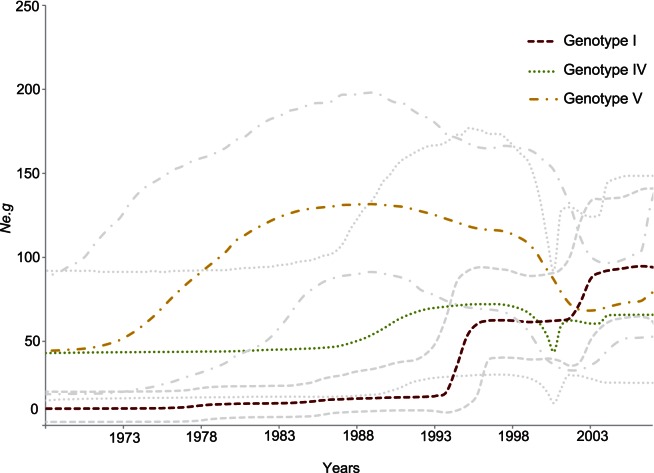
Demographic history for each genotype.Overlay of Bayesian skyline plot showing the Ne.g. (product of the effective population size and the generation length) for each DENV-1 genotypes. Ninety-five percent high probability densities (95% HPD) are showed as thin discontinuous lines around each mean plot.